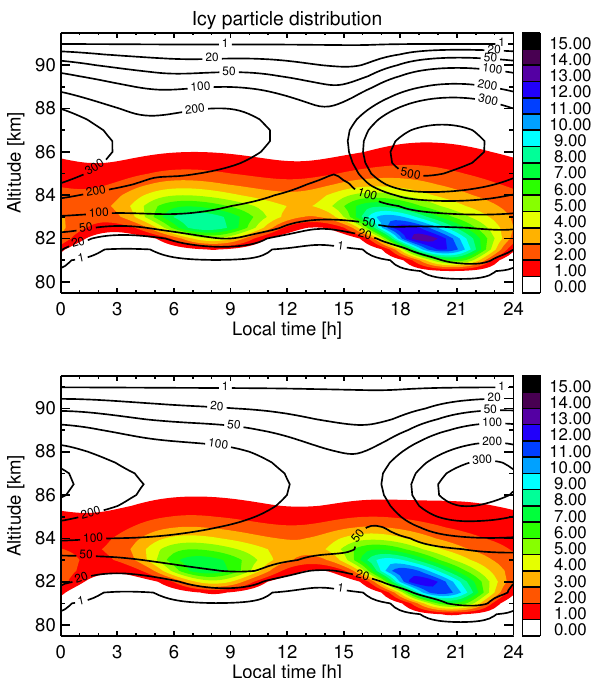
Fig. 1. Modelled icy particles at 75 ◦ S during the period of one day (14 January). The black contour lines indicate the total number of icy particles per cm 3 , and the filled color contours show the total ice mass in units of 10 − 15 gcm − 3 . The particles in the smallest radius bin are excluded. Upper panel: simulation with prescribed 100cm − 3 icy particles in the smallest radius bin. Lower panel: sim- ulation with calculated heterogeneous nucleation assuming perfect wettability of the CN (for details see Sect. 6.2).